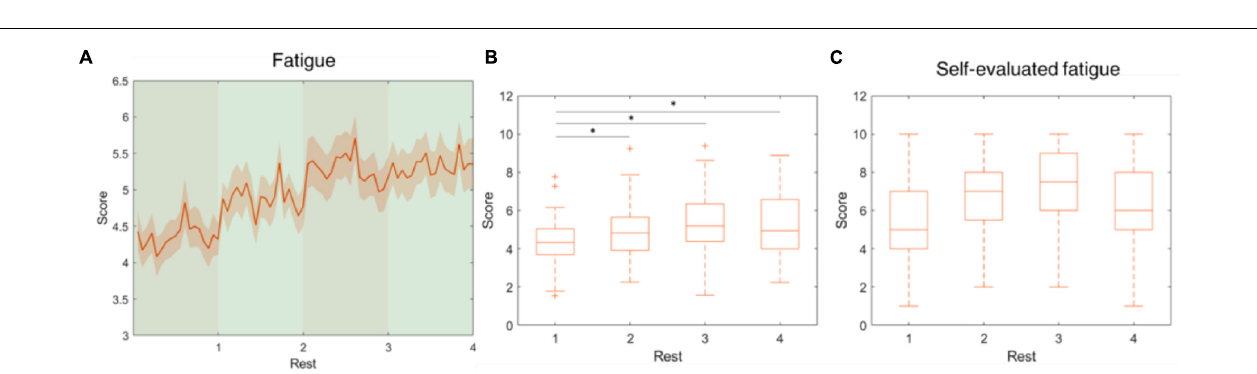
FIGURE 5 | Attention level fluctuations during the whole experiment. This parameter was developed using theta and alpha-band power at F3, Fz, and F4. (A) The average attention level across the four session and rest periods. (B) The attention level during the sessions decreased over time and was significantly higher than during the following rest periods in pairs 2 and 3. *indicates that the difference between the two groups was statistically significant. The whiskers extend to the most extreme data points not considered outliers, and the outliers are plotted individually using the “+” marker symbol.